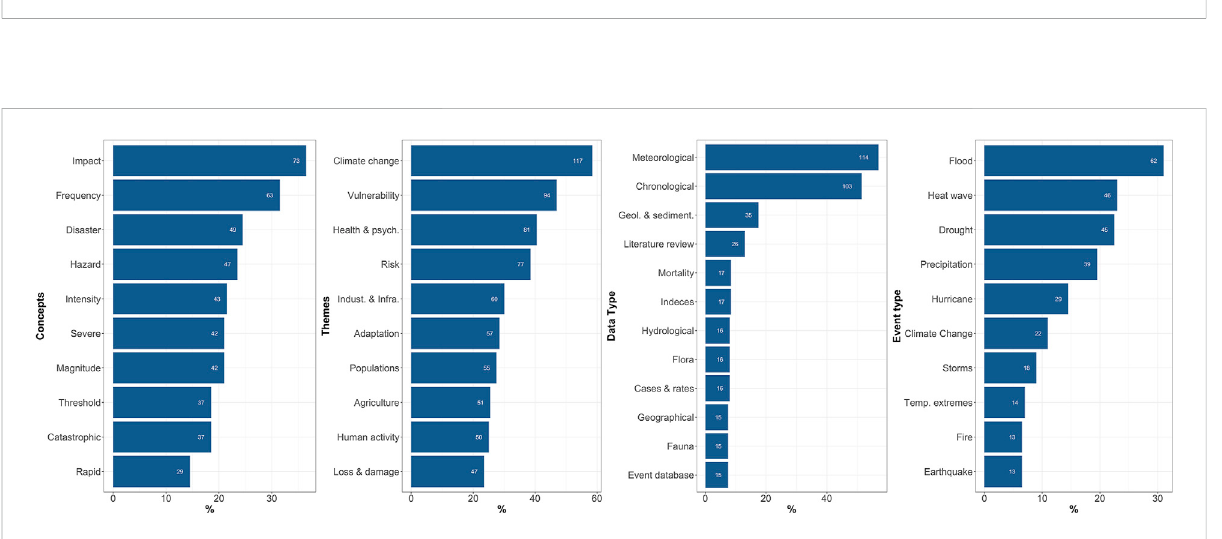
FIGURE 1 Number of publicationsper year (A) and adjusted for through-time increases in publication volume (B) . Note that the two graphs have different starting years(GraphA startsat1996,whereas GraphBstartsat1997).This isbecauseofthewaybywhich weattemptedto correctforthrough-time increases in publication volume ( see